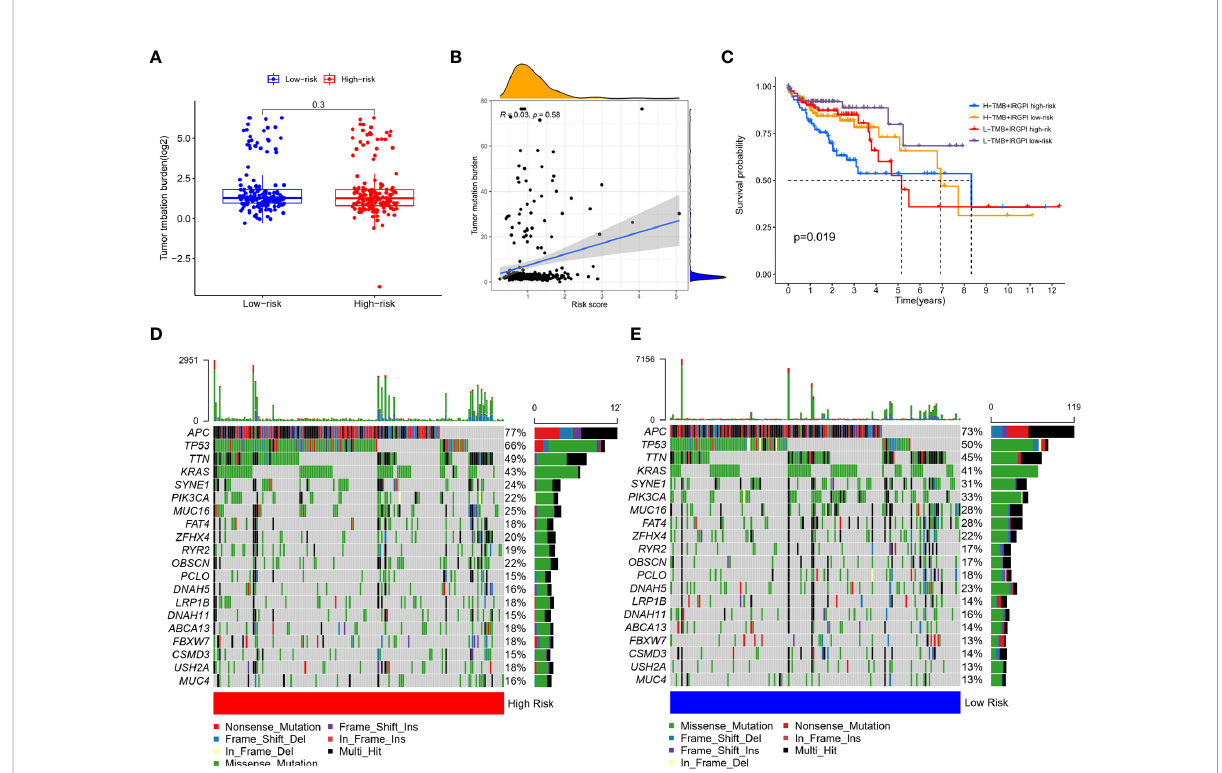
FIGURE 4 Correlation of IRGPI with clinical features. (A) TMB in high-risk and low-risk group showed no statistical difference. (B) Spearman correlation analysis of the correlation between IRGPI and TMB showed that the prognostic index was not correlated with TMB. (C) Survival of high -risk and low-risk group patients with different TMB levels. Patients with IRGPI low-risk and low TMB had the best survival. The 20 genes with the highest mutation frequency in high-risk (D) and low-risk (E) group. High-risk group had higher mutation frequency of APC, TP53, TTN, OBSCN and lower mutation frequency of SYNE1, PIK3CA and